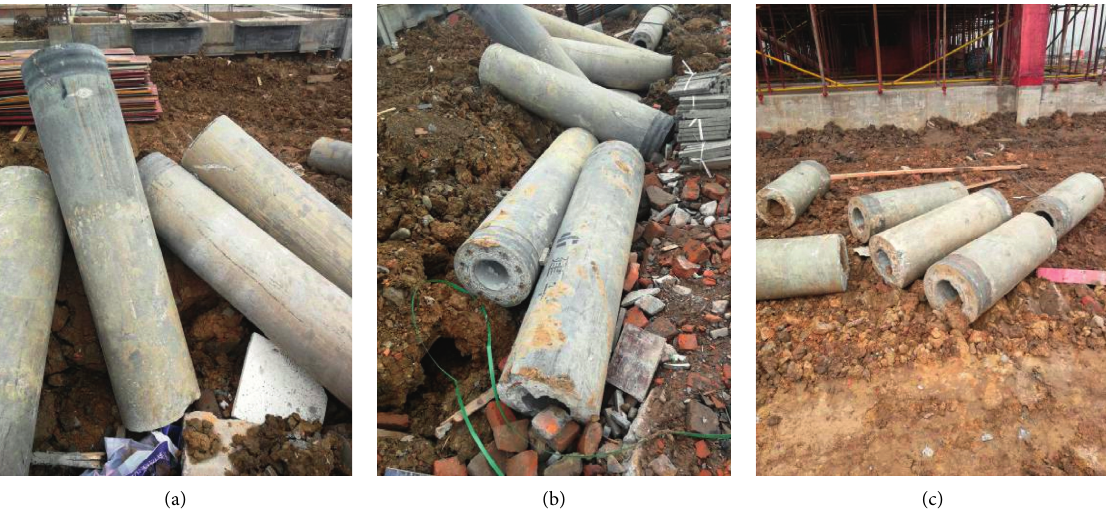
Figure 2: The section of the pile that has been cut